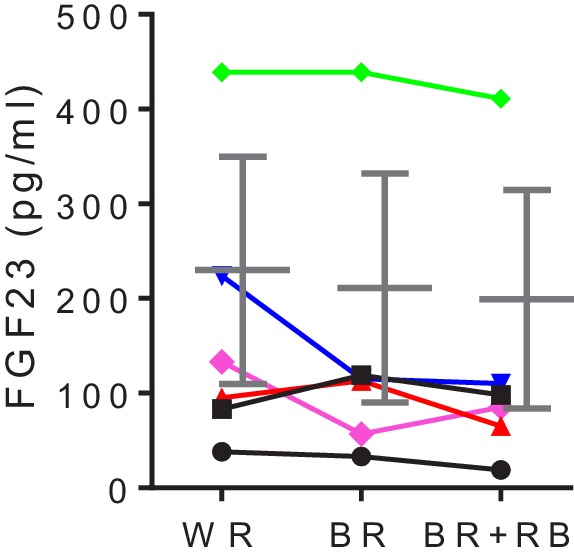
High-phytate diets dysregulate mineral and phosphate metabolism in humans.Time-course analysis of serum levels of intact FGF23 for three consecutive phytate doses. Statistical significance was tested by repeated measure ANOVA between subjects and groups. All data are presented as the mean ± SD for each dose (n = 6 per dose).